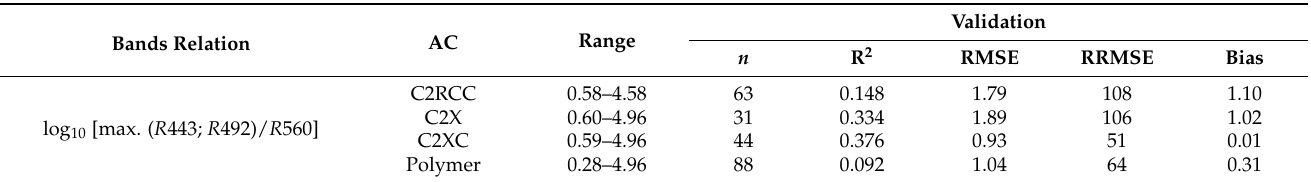
Table A5. Chl_a above 5 mg/m 3 validation results for in situ spectrometry waters quality algorithms and AC type.